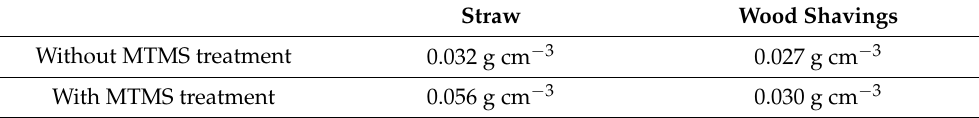
Table 1. Bulk density of the straw and wood shavings before and after MTMS treatment. Straw Wood Shavings Without MTMS treatment 0.032 g cm − 3 0.027 g cm − 3 With MTMS treatment 0.056 g cm − 3 0.030 g cm −